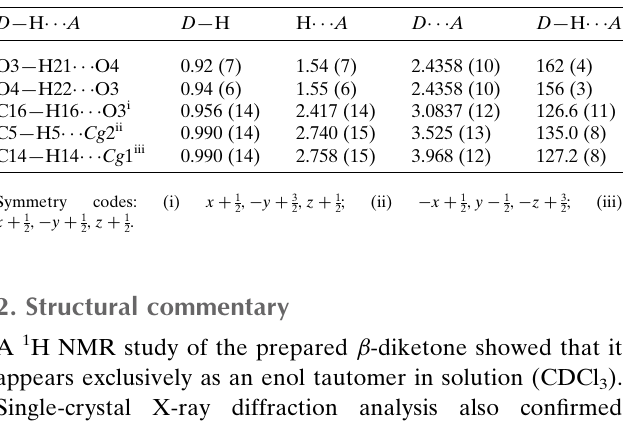
Table 1 Hydrogen-bond geometry (A˚ , (cid:3) ). Cg 1 and Cg 2 are the centroids of the C3–C8 and C12–C17 rings, respectively.